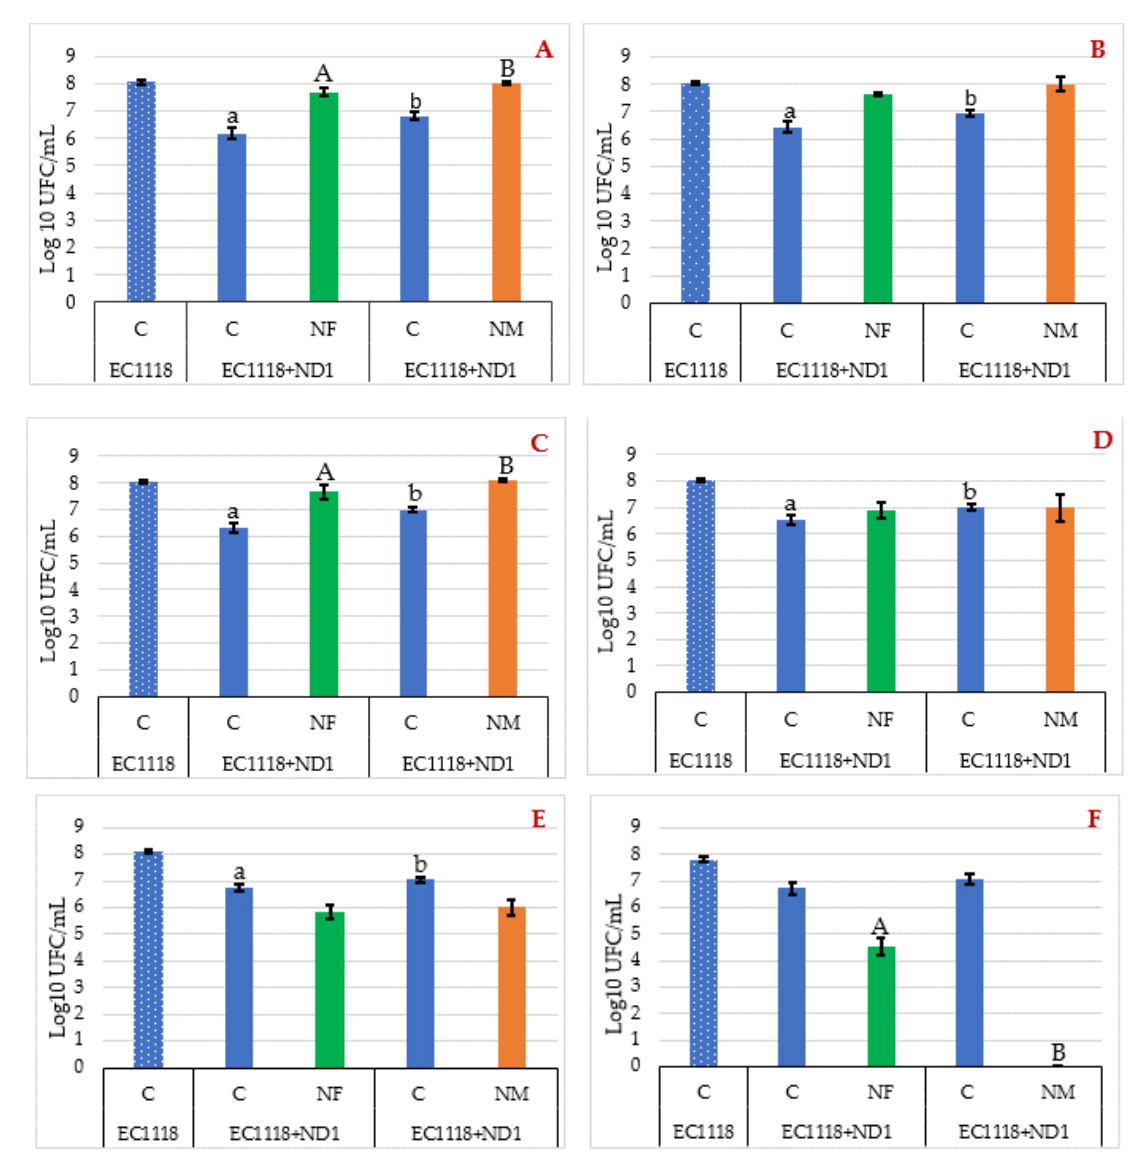
Figure 3. Yeast cell count detected at different times: ( A ) 2 days; ( B ) 3 days; ( C ) 4 days; ( D ) 7 days; ( E ) 9 days; ( F ) 11 days of fermentations inoculated with S. cerevisiae EC1118 in mixed culture with H. osmophila ND1 strain as free (NF) and microencapsulated (NM) cells. As control, pure fermentation with EC1118 was used (C). Data are the means of triplicate experiments ± standard deviation. Letters on plot bars indicate significant differences ( p < 0.05) in cell count within EC1118 ( a , b ) and ND1 ( A , B ) in the two mixed starter fermentations.